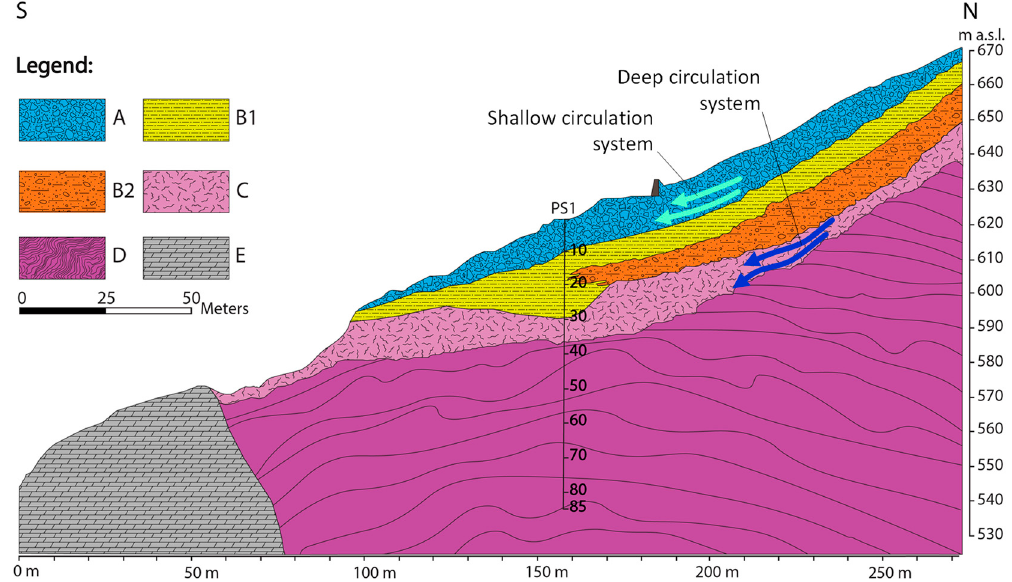
Figure 3. Cross-section A–A of the Sant’Andrea landslide with indications about the hydrogeological